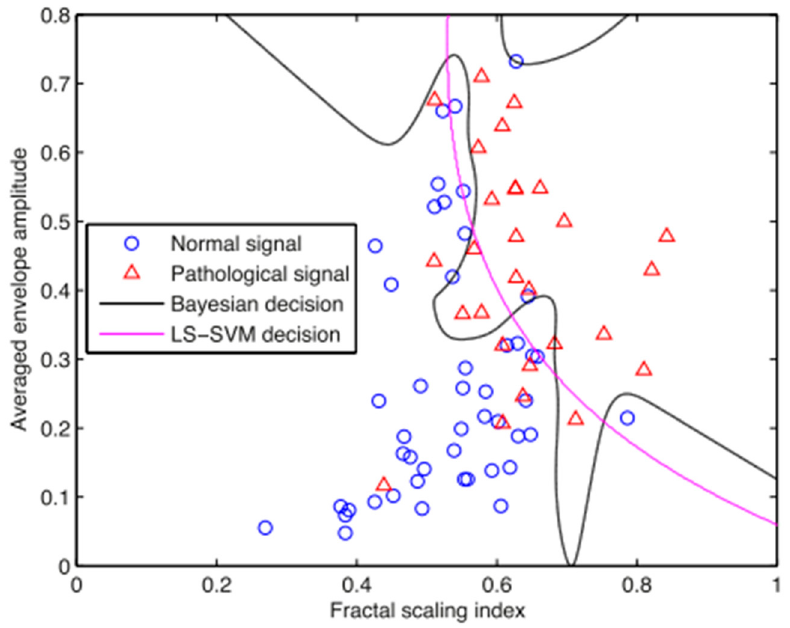
Figure 7. Decision boundaries provided by the least-square support vector machine (LS-SVM) with polynomial kernels and the Bayesian decision rule applied on VAG signals [36]. Table 2. A sample of the literature available on the use of the vibration arthrography technique on knee joints as a classification